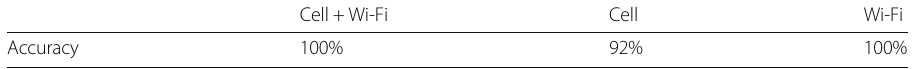
Table 1 The accuracy of level classification in the first-fold cross validation Cell +